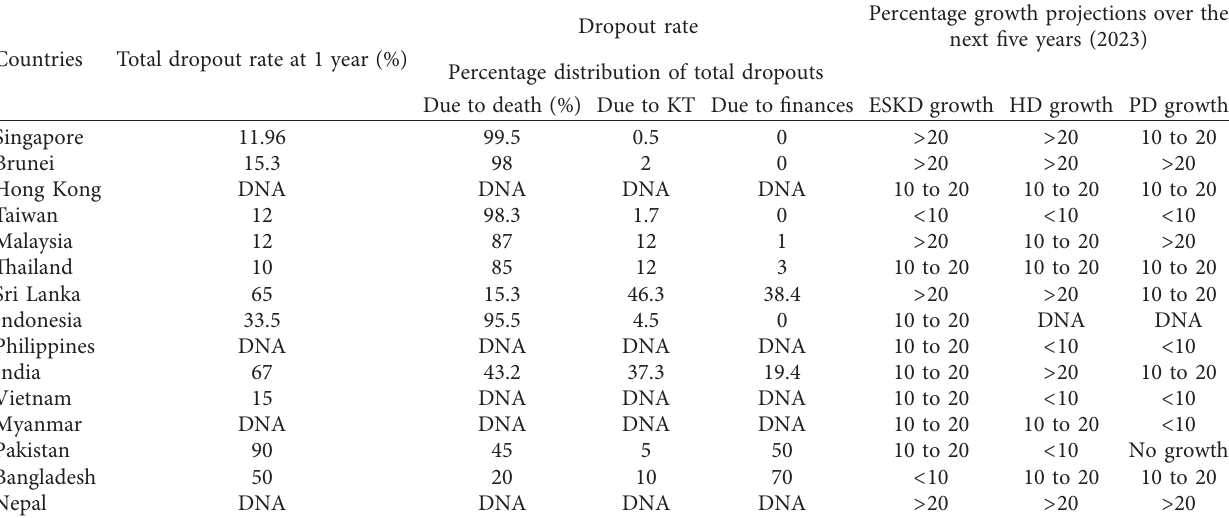
Table 4: Country wise dropout rate & growth projections.